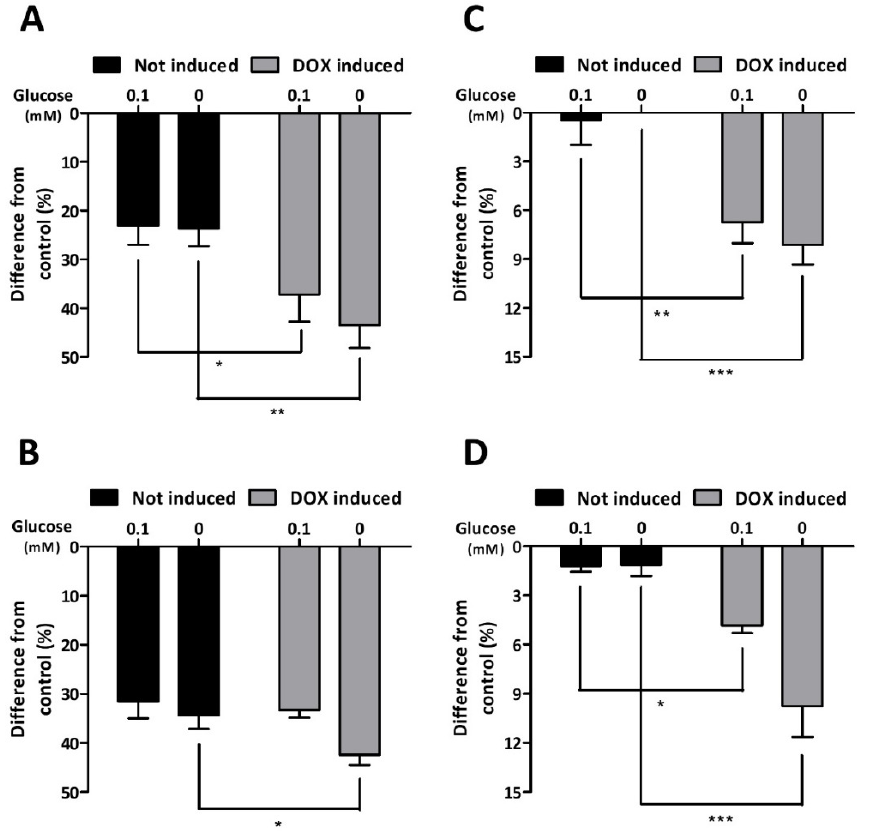
Figure 5. Influence of α 1 DN expression on the metabolic activity of C6 cells. C6-rtTA-AMPK-DN cells induced or not with DOX (2 µg/mL, 24 h) were submitted to severe (0.1 mM) or total (0 mM) glucose deprivation for 3 ( A – C ) and 6 h ( B – D ). Their metabolic activity and their intracellular ATP content were assessed by MTT colorimetric assay ( A , B ) or by a luciferase-based assay ( C , D ), respectively. Histograms represent the difference from the control condition (25 mM of glucose) and show means ± SEM from four ( C , D ) or five ( A , B ) independent experiments, in which every experimental condition was tested in octuplicate. Statistical analyses were performed by two-way ANOVA followed by Bonferroni’s multiple comparison test (* p < 0.05, ** p < 0.01, *** p < 0.001).